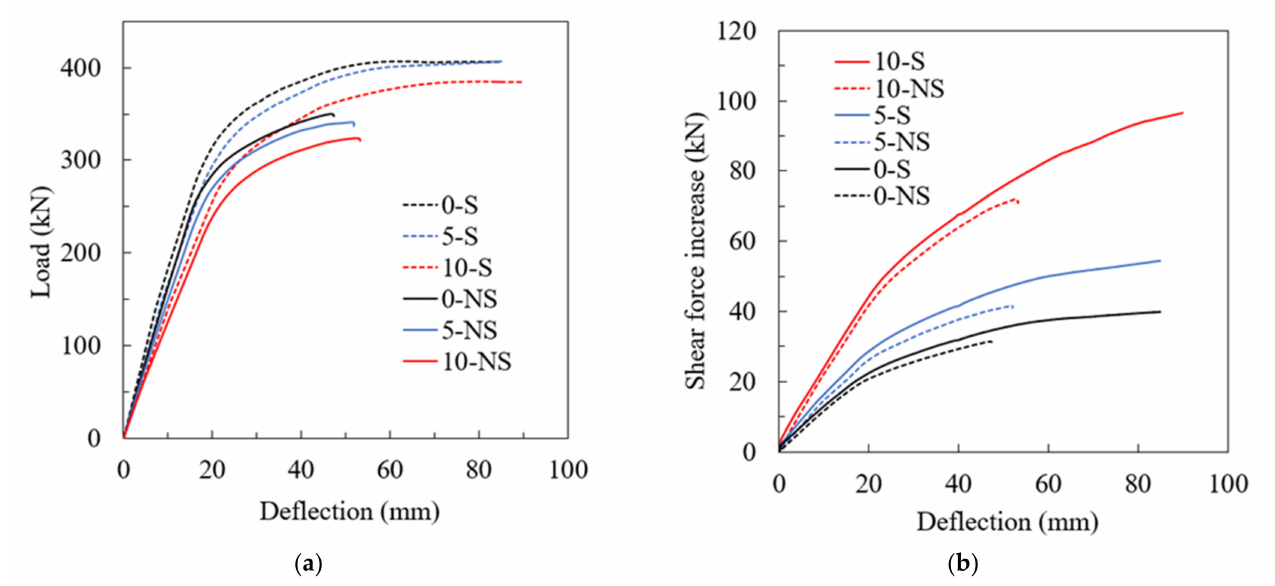
Figure 16. ( a ) Load versus deflection curves and ( b ) the increase in shear force versus deflection curves for the S and NS samples after steps 0, 5, and